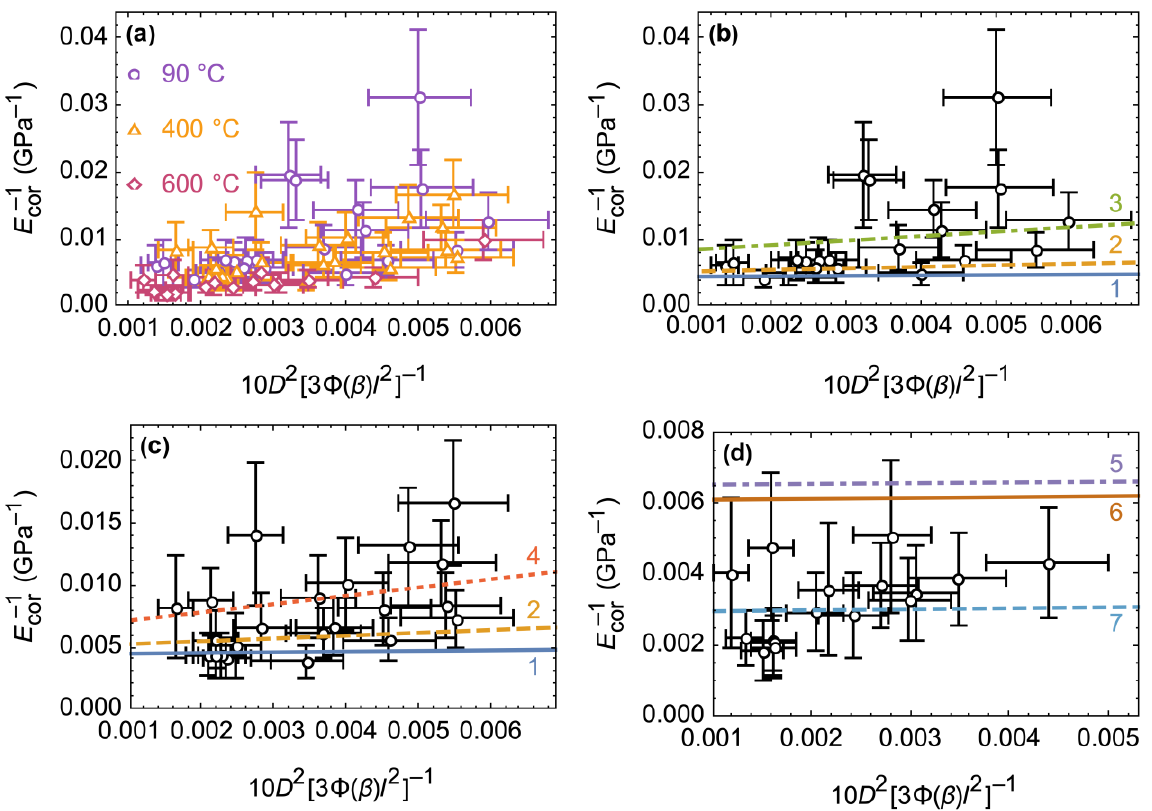
Figure 7. Linearization of the experimental data according to Equation (9) presented ( a ) in common range, and separately for ( b ) 90 ◦ C, ( c ) 400 ◦ C, and ( d ) 600 ◦ C. The lines show the dependences calculated with Equation (9) using the E G and G values, respectively: 1–222 and 19 GPa; 2–196 and 4 GPa; 3–126 and 1.5 GPa; 4–152 and 1.5 GPa; 5–153 and 54 GPa; 6–164 and 40 GPa; 7–338 and 36 GPa. The values were taken from Table 1, measurement results (inset in Figure 6), as well as from previously published data [21,25], see